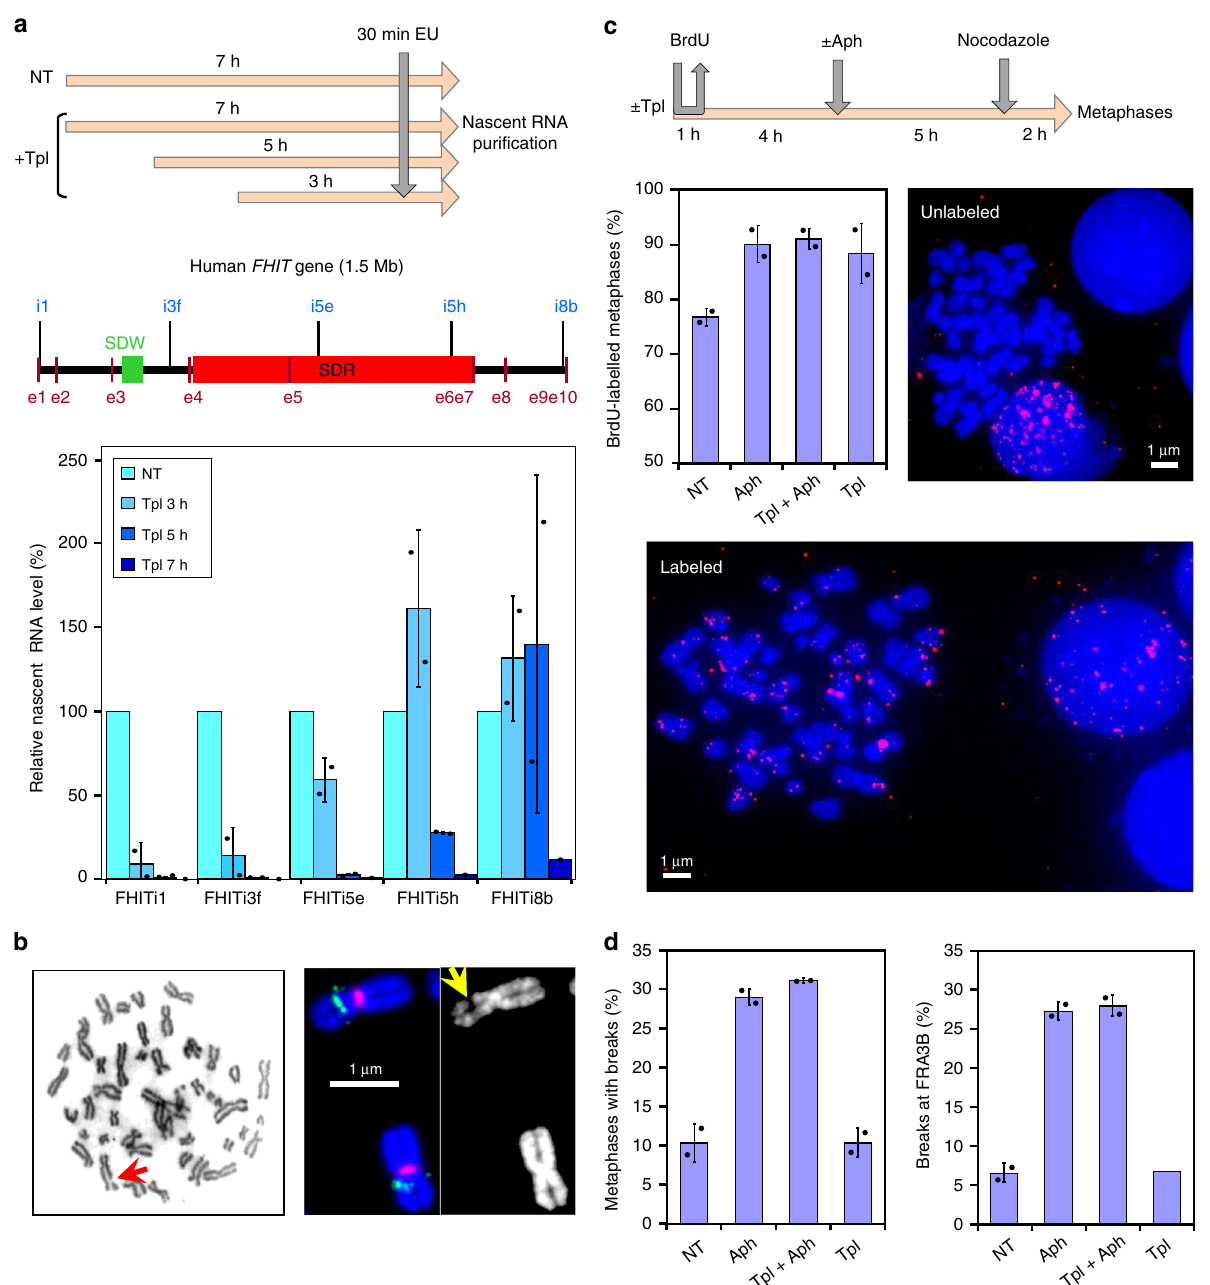
Fig. 4 Short-term inhibition of transcription by triptolide does not impact CFS instability. a Determination of the minimal time permitting clearing of the FHIT gene from ongoing transcription. Upper panel: scheme of the experiments. Untreated cells (NT) and cells treated with 1 μ M triptolide (Tpl) for the indicated periods of time were pulse labelled with EU for 30 min before recovery. Nascent RNAs were prepared by the Click-It method and quanti fi ed by RT-qPCR. Middle panel: map of the human FHIT gene with the position of exons (e1 – e10), T-SDW/SDR and intronic primer pairs (i1 – i8b) used for quanti fi cation. Lower panel: quanti fi cation of nascent RNA along FHIT at the different times of Tpl treatment. b Examples of chromosome breaks in cells treated with 600 nM Aph for 7 h. Left panel: metaphase plate displaying a break (red arrow) on Giemsa-stained chromosomes. Right panel: break at FRA3B (yellow arrow) visualized after DAPI staining and FISH with probes speci fi c to the FHIT gene (green) and to the centromere of chromosome 3 (red). Contrast of DAPI-stained chromosomes (rightmost panel) was enhanced to better show the break. c Upper panel: scheme of the experiments: cells were treated with 1 μ M triptolide and 600 nM Aph, alone or in combination, for the indicated times before metaphase preparation. In all conditions, cells were pulse labelled for 1 h with 30 µ M BrdU at the beginning of the experiments and treated for 2 h with 200 nM nocodazole at the end of experiments to enrich the populations in metaphase cells. Lower panels: the fraction of BrdU-labelled metaphases was scored after DAPI staining and immuno fl uorescence revelation with anti-BrdU antibodies. Examples of BrdU-labelled and unlabelled metaphases are shown. Note also the presence of labelled and unlabelled interphase nuclei. d Determination of the frequencies of total chromosome breaks (left panel) and breaks at FRA3B (right panel). Breaks were scored as in b . Experiments shown in a, c and d were carried out twice and the error bars represent the SD. Source data are provided as a Source Data fi